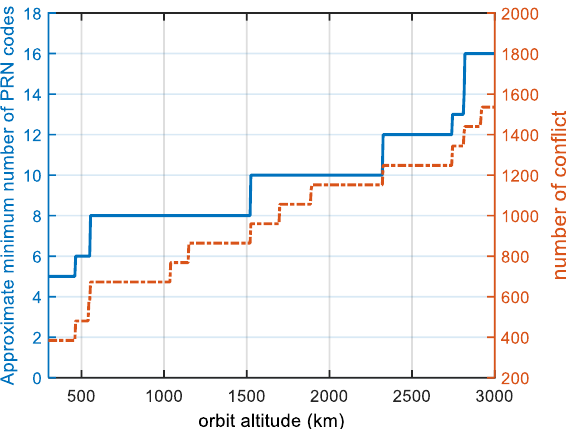
Figure 13. Graph of the orbital altitude and approximate minimum number of groups. The blue line shows the approximate minimum number of PRN codes, and the orange line shows the number of conflicts . This is a walker constellation similar to Globalstar, which is divided into 8 orbits with 11